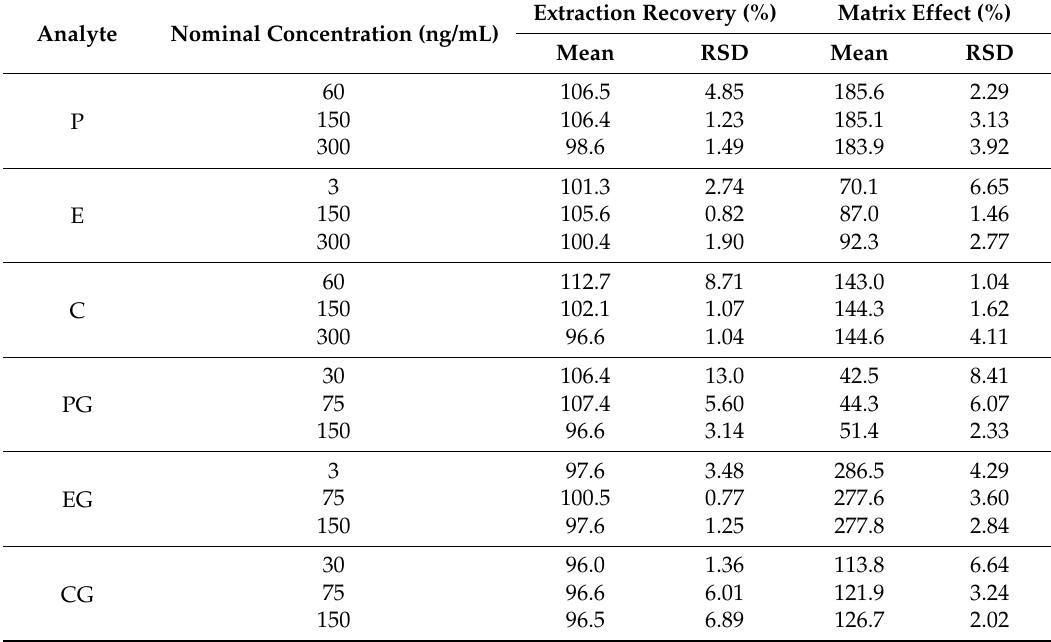
Table 3. Extraction recovery and matrix effect of anthraquinones in rat plasma ( n = 3).